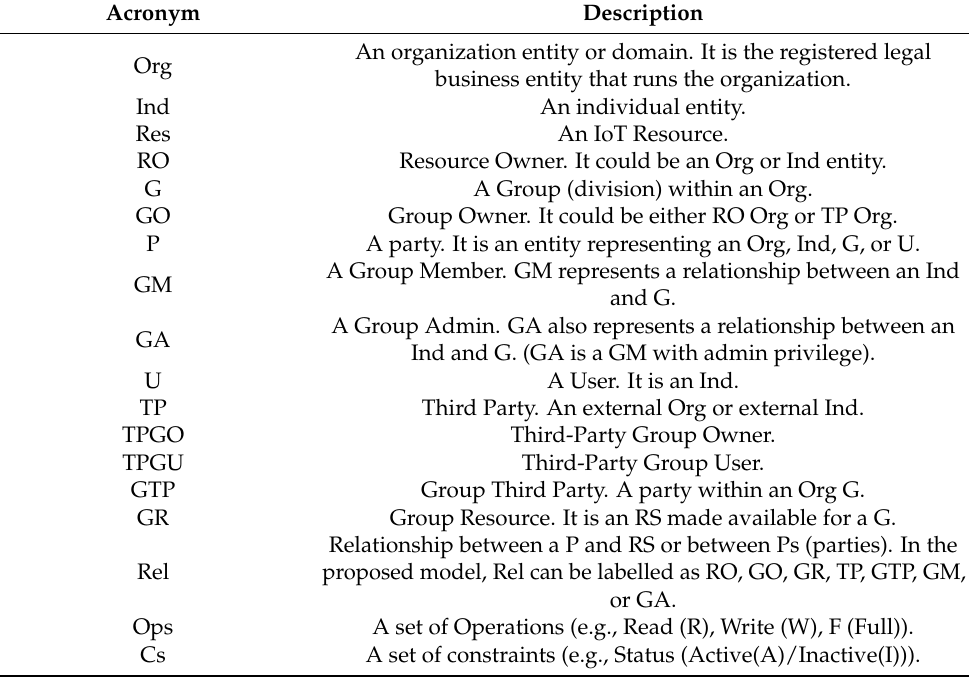
Table 1. Acronyms and